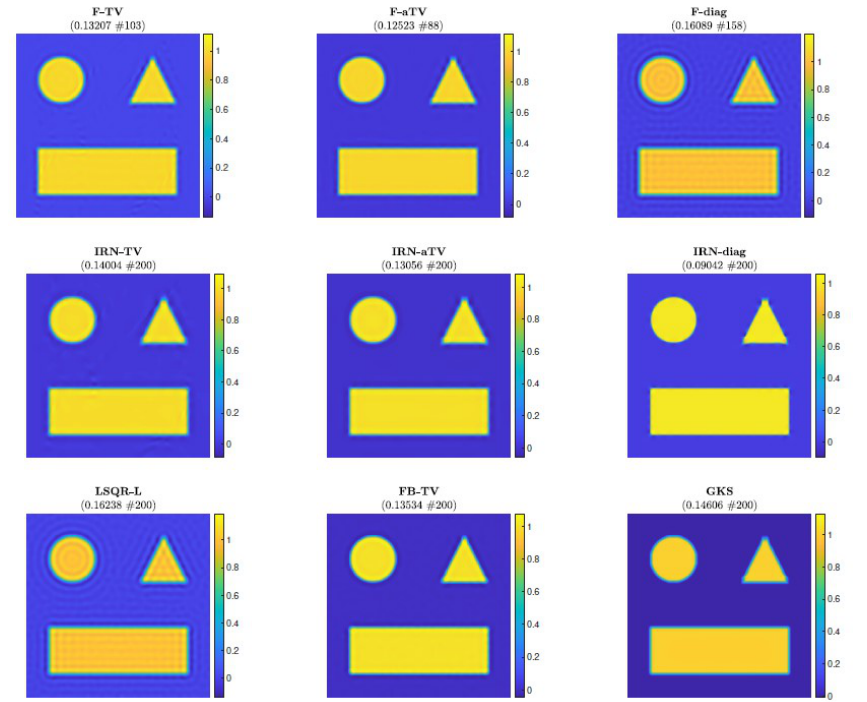
Figure 4. Experiment 1, with N = 256 . Reconstructions achieved by various methods at the stopping iteration (if a stopping criterion is used, else the maximum iteration). The RRE and stopping iteration for each reconstruction are displayed in the frame